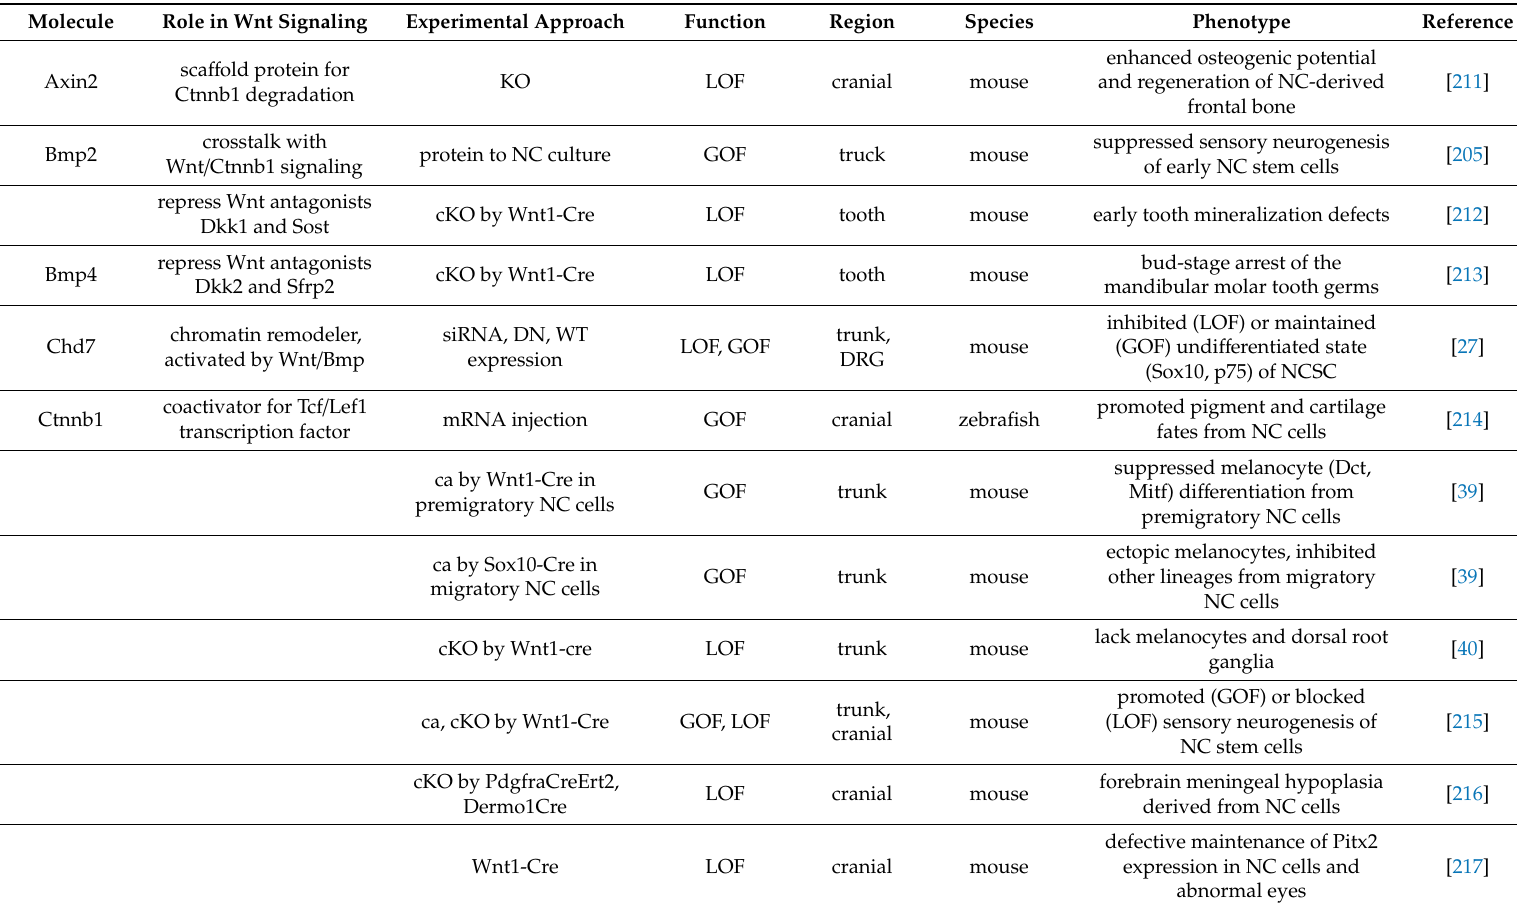
Table 3. Experimental findings of Wnt signaling molecules, modulators, and e ff ectors in vertebrate neural crest proliferation and di ff erentiation. (ca, conditional active; cKO, conditional knockout; GOF, gain of function; KO, knockout; LOF, loss of function; MO;